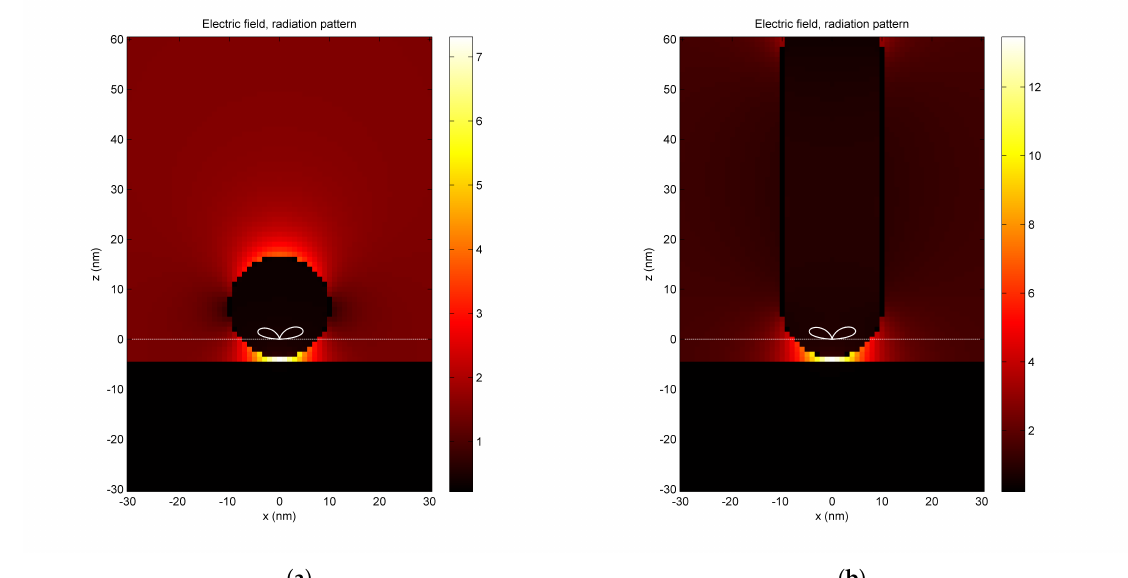
Figure 2. Near-field enhancement between a gold nanofilm and: ( a ) a spherical particle (radius = 10 nm); ( b ) a rod (r = 10 nm, length = 70 nm) both placed 1 nm above a gold surface. A p-polarized electromagnetic plane wave irradiates at λ = 1040 nm, with an angle of incidence θ = 88 ◦ . The white lines represent the direction and magnitude of the Poynting vector of far-field scattered laser